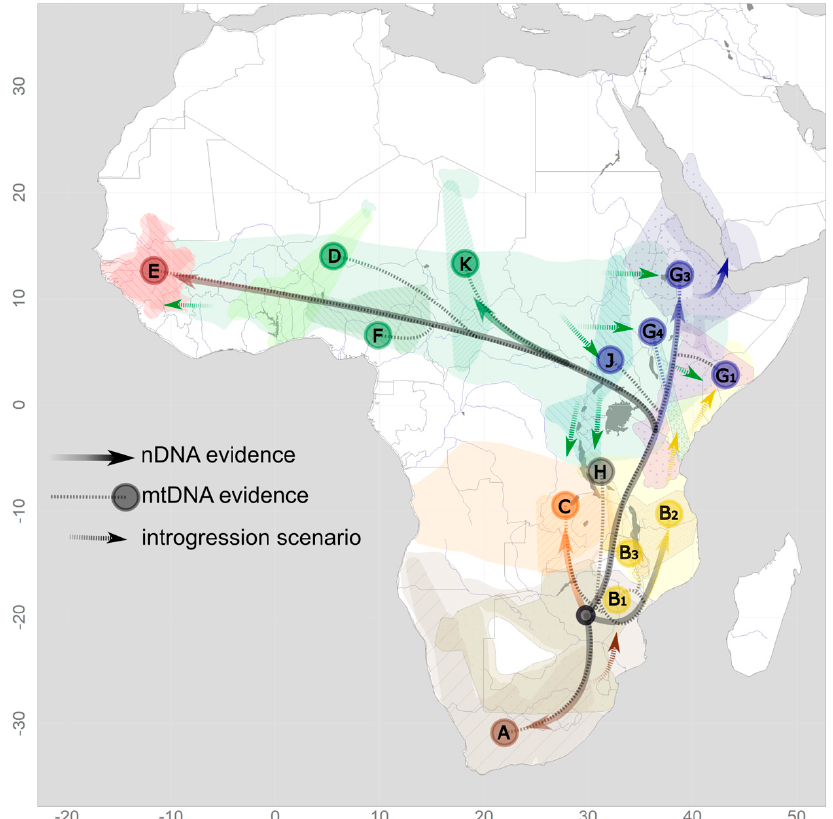
Figure 3. A phylogeographic scenario of baboons derived from nDNA (solid lines) and mtDNA (dotted lines) evidence. Letters indicate mtDNA clades as in Figure 2, with the color of the circle indicating the hypothesized proto-species.